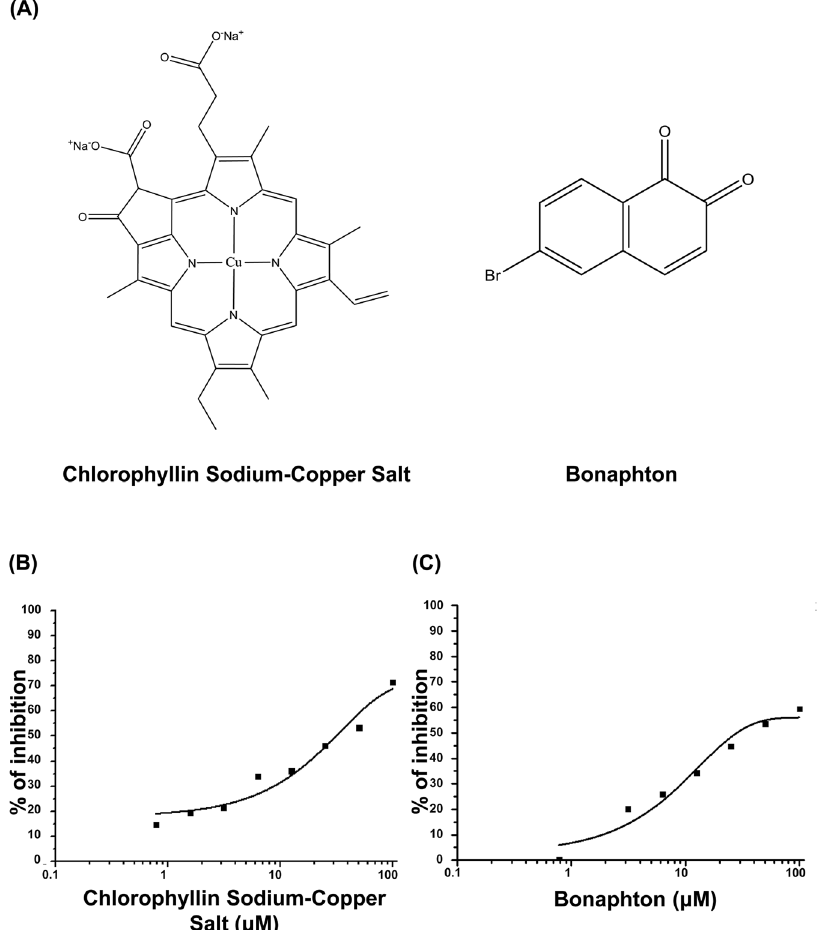
Figure 2. Two promising drugs obtained by FCS screening. ( A ) Chemical structures and names of the two candidate drugs: chlorophyllin sodium copper salt and bonaphton. ( B ) and ( C ) Binding inhibition curve based on the drug concentration. The two drugs were independently added to a mixed solution of GST-Keap1-DGR and Nrf2-ETGE at various concentrations (0.78–100 μ M). The IC 50 values of chlorophyllin sodium copper salt and bonaphton were 35.7 and 37.9 μ M,